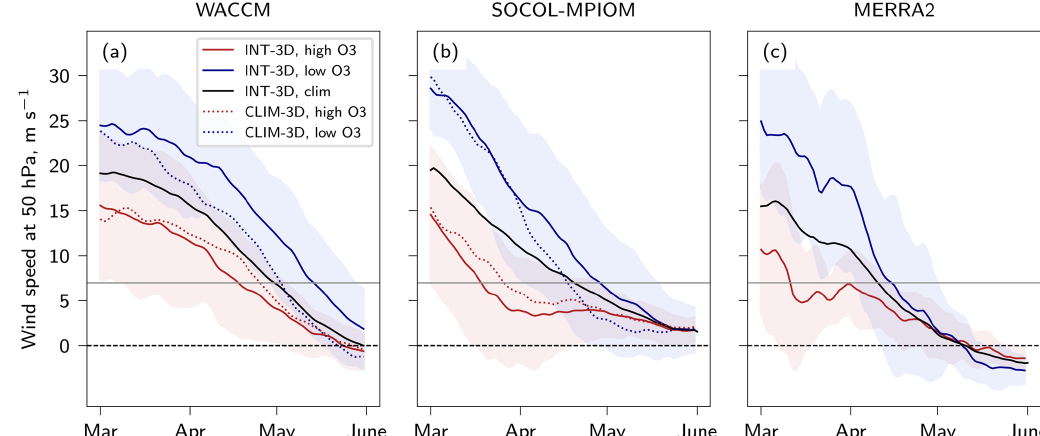
Figure A1. Zonal wind evolution in high- and low-ozone springs. Zonal mean zonal wind at 50hPa averaged between 55 and 75 ◦ N in high-ozone (red) and low-ozone (blue) springs in INT-3D (solid line) and CLIM-3D (stippled line) and the wind climatology (black) in (a) WACCM and (b) SOCOL-MPIOM as well as in (c) MERRA2. The grey line indicates the wind threshold of 7ms − 1 used to define the FSW date at 50hPa. Shaded areas show the standard deviation in high- and low-ozone springs in INT-3D simulations.